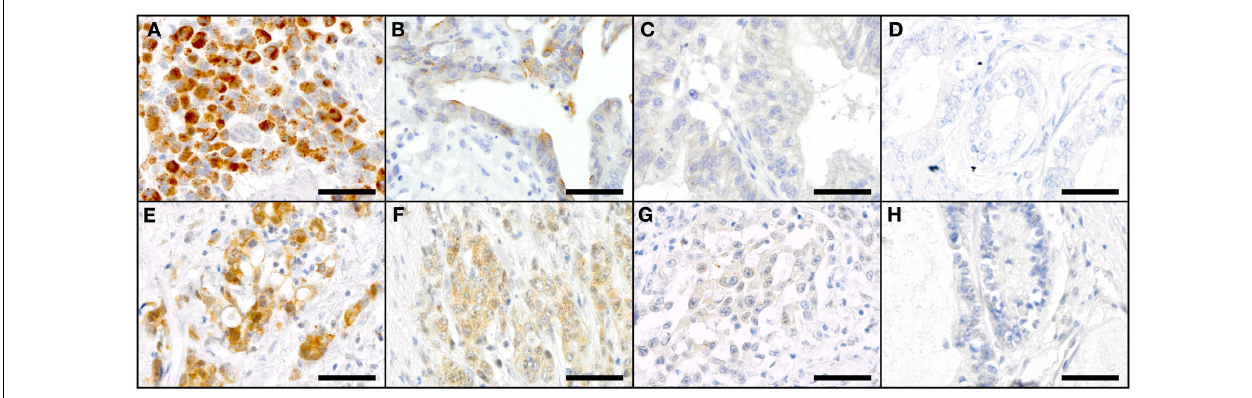
FIGURE 2 | Staining patterns for NOTCH1 (A–D) and NOTCH2 (E–H) in primary resected GC specimen . NOTCH1: (A) high-intensity cytoplasmic staining (SI 12), (B) medium-intensity cytoplasmic staining (SI 4), (C) low-intensity cytoplasmic staining (SI 2), and (D) negative cytoplasmic staining for NOTCH1 (SI 0); NOTCH2: (E) high-intensity cytoplasmic